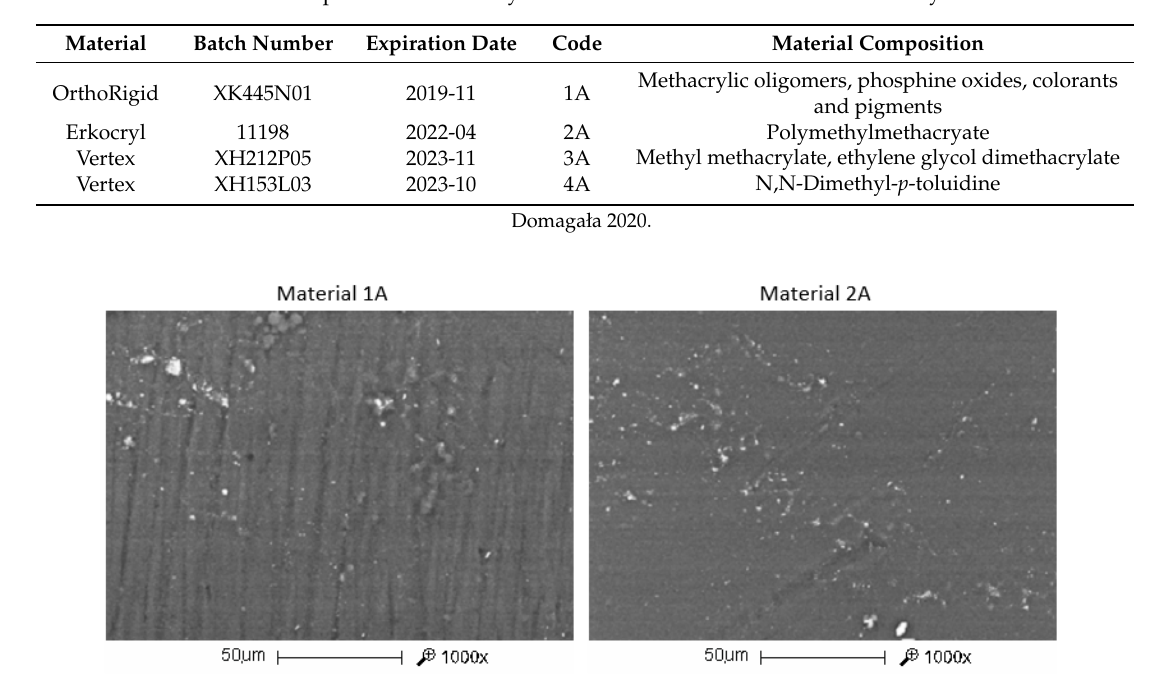
Table 1. Specifications of acrylic resin-based materials used in this study.